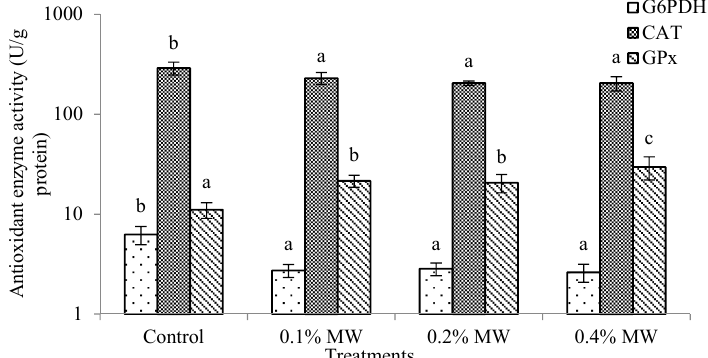
Fig. 2. Antioxidant enzyme activities in entire body of galba truncatula exposed to 0.1%, 0.2%, and 0.4% of municipal wastewater for 14